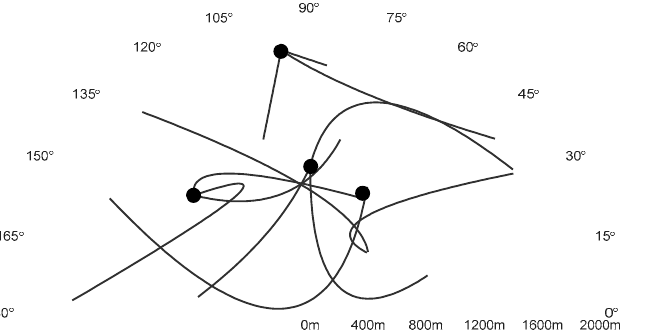
Figure 11. Target trajectories in example 2 (CA motion model), where targets are born from the black dot ● . Table 3. List of initial target states in the CA motion model.